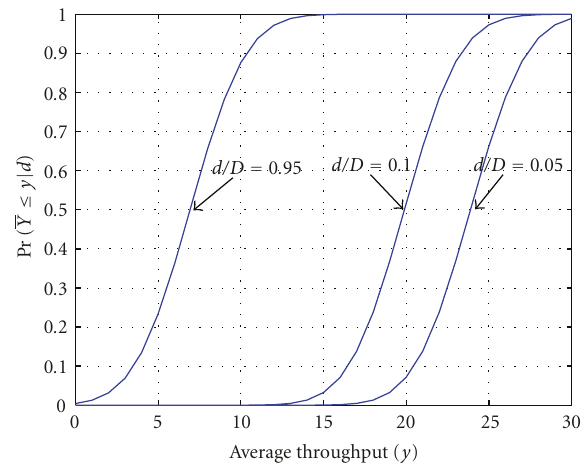
Figure 6: Comparison of the cdf of short-term averaged through- put across users, at preselected distances such that d/D = (0.05, 0.10, 0.95).